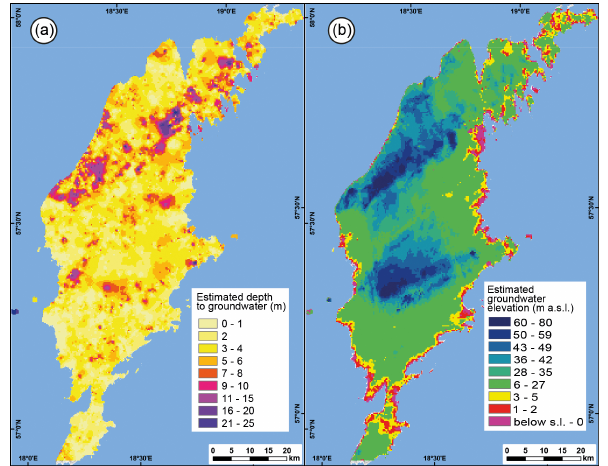
Figure 4. (a) Estimated depth to groundwater. Values for each well were interpolated to one surface. (b) The estimated groundwater elevation across Gotland, calculated by subtracting the estimated depth to groundwater from the topography.